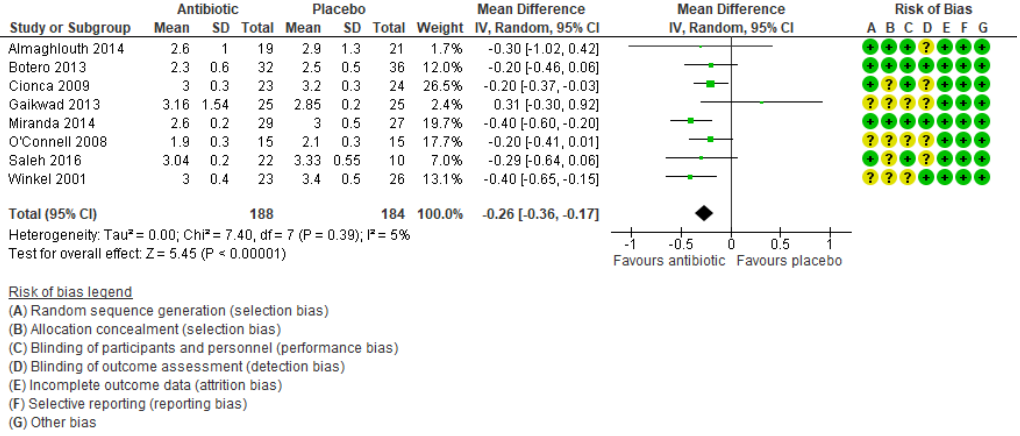
Figure 3. Meta-analysis of probing depth (in mm) after three months for studies assessing mechanical debridement with antibiotics in the treatment of periodontitis.